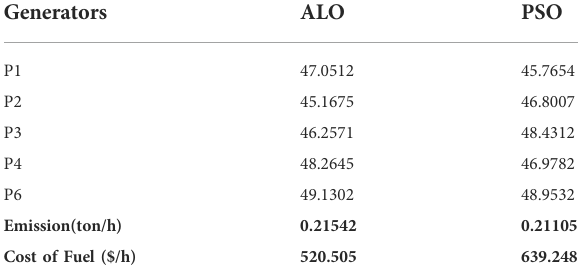
TABLE 1 ALO and PSO were used to optimise the cost of a fi ve- generator system. Generators